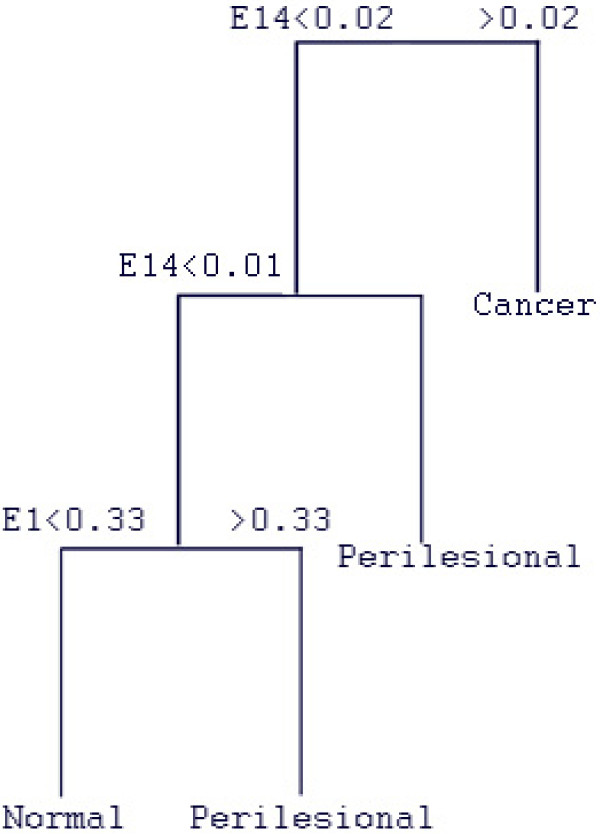
Example Classification Tree based on ApSE analysis for a training set. For this particular gene cluster, key decisions were based on the values of ApSE at R = 0.1 (E1) and at R = 1.4 (E14). All subjects whose ApSE value at R = 1.4 was greater than 0.02 were classed as belonging to the cancer group. For subjects with an ApSE value at R = 1.4 less than 0.02 were further split into two groups. If the ApSE at R = 1.4 was above 0.01, they were assigned to the perilesional group. In the subset of subjects whose ApSE at R = 1.4 was less than 0.01, the ApSE at R = 0.1 was used to make the final decision: subjects whose ApSE at R = 0.1 fell below 0.33 were classed as belonging to the normal group, with the remainder (ApSE at R = 0.1 > 0.33) falling into the perilesional group. These decision rules were then applied to a corresponding validation set of subjects (for the same cluster of genes) to predict the biopsy class.